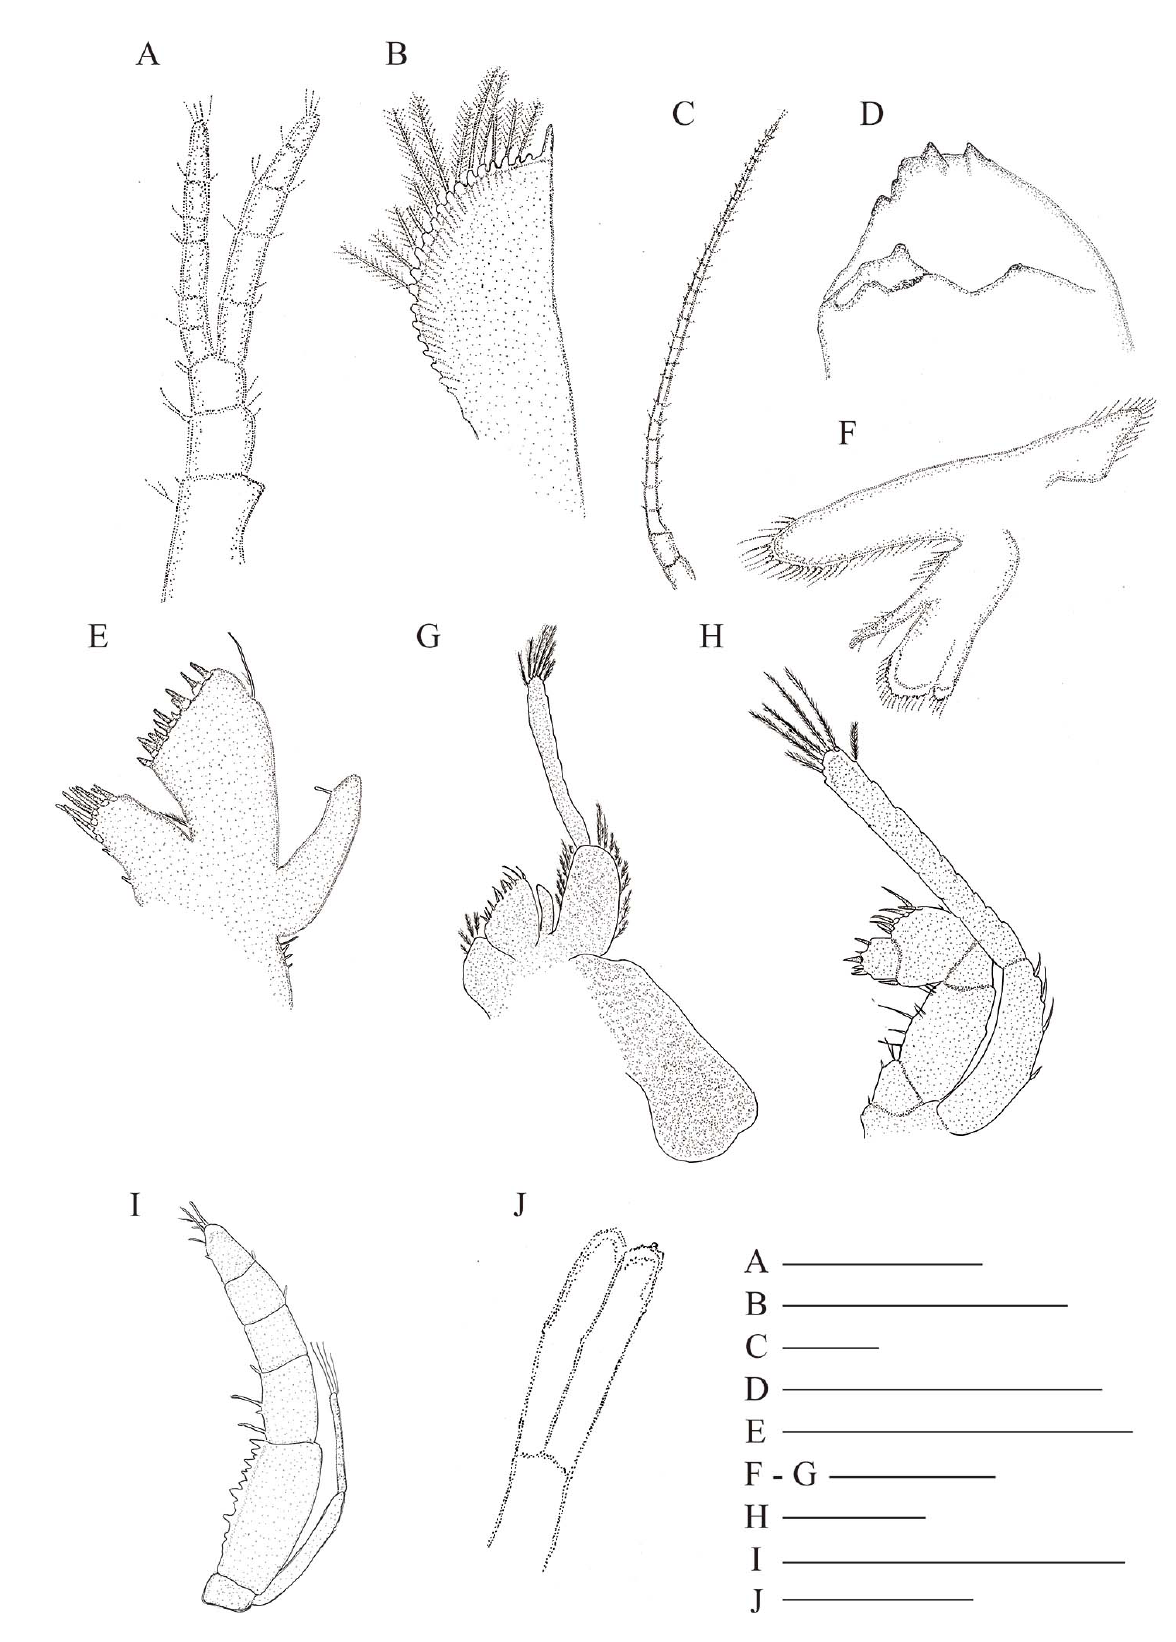
Figure 10. Juvenile Stage II of Procambarus virginalis . ( A ) Antenna 1, dorsal view; ( B ) antennal scale, dorsal view; ( C ) flagellum of antenna 2, dorsal view; ( D ) mandible, view of inside of mouth; ( E ) maxilla 1, oral view; ( F ) maxilla 2, oral view; ( G ) first maxilliped, oral view; ( H ) second maxilliped, oral view; ( I ) third maxilliped, oral view; ( J ) pleopod. Scale bar: 0.25